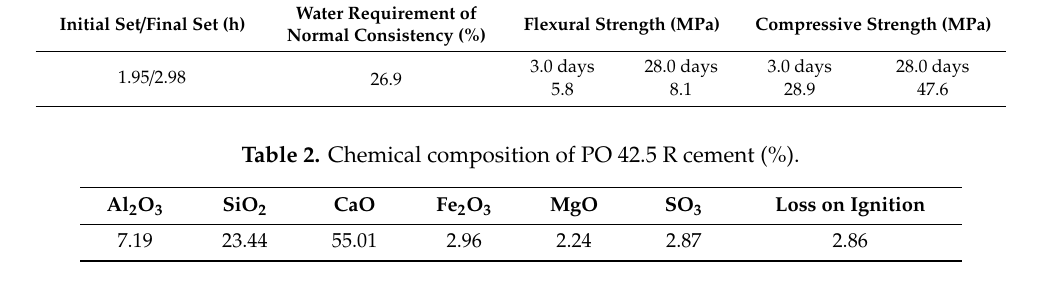
Table 3. Chemical composition of class-I fly ash (%).